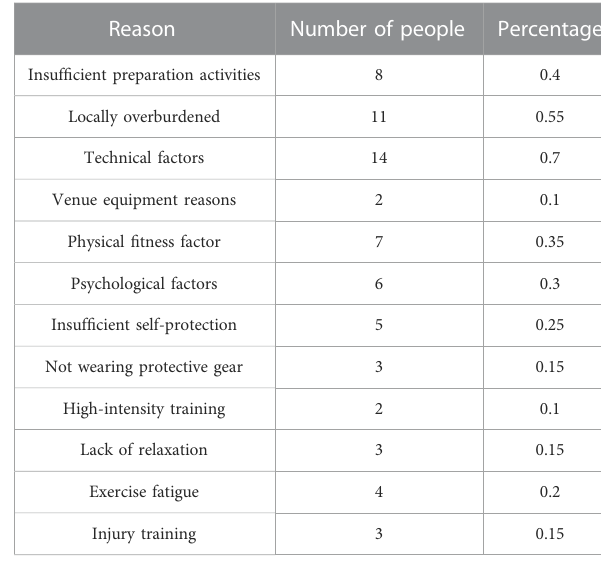
TABLE 6 Statistics of injury types.